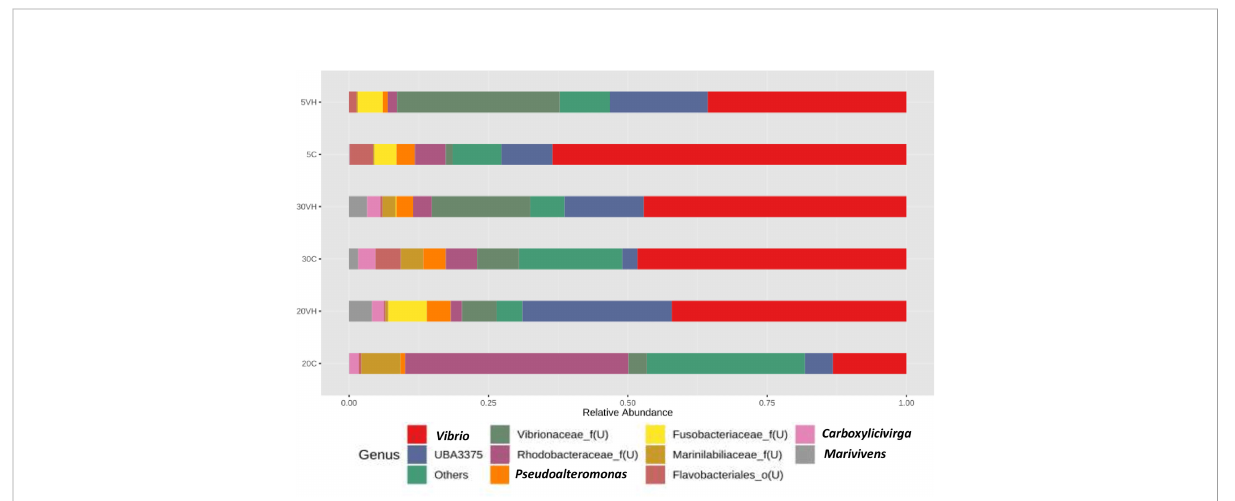
FIGURE 5 Genus level gut bacterial pro fi les of Litopenaues vannamei cultured at different salinity levels and exposed to Vibrio harveyi (VH: Vibrio harveyi infected group and C, Control group; 5, 5 ppt, 20, 20 ppt and 30, 30